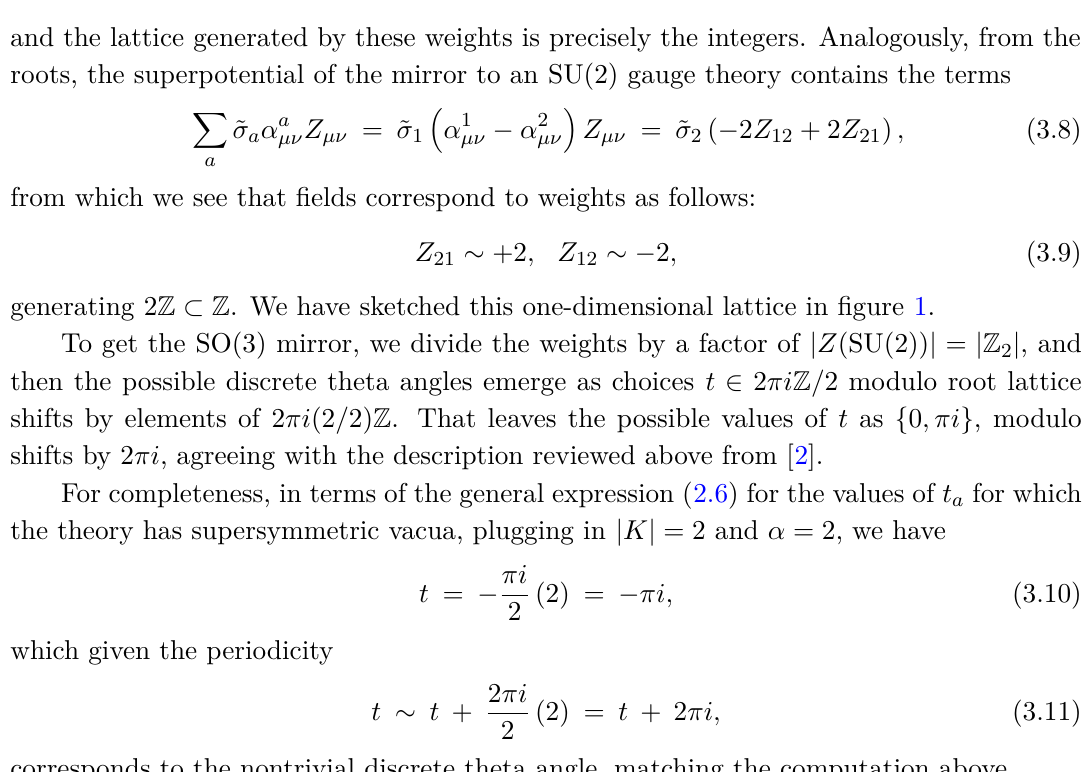
Figure 1 . Schematic illustration of weight and root lattice for SU(2) . Solid circles indicate points on both lattices; empty circles indicate points on the weight lattice that are not also on the root